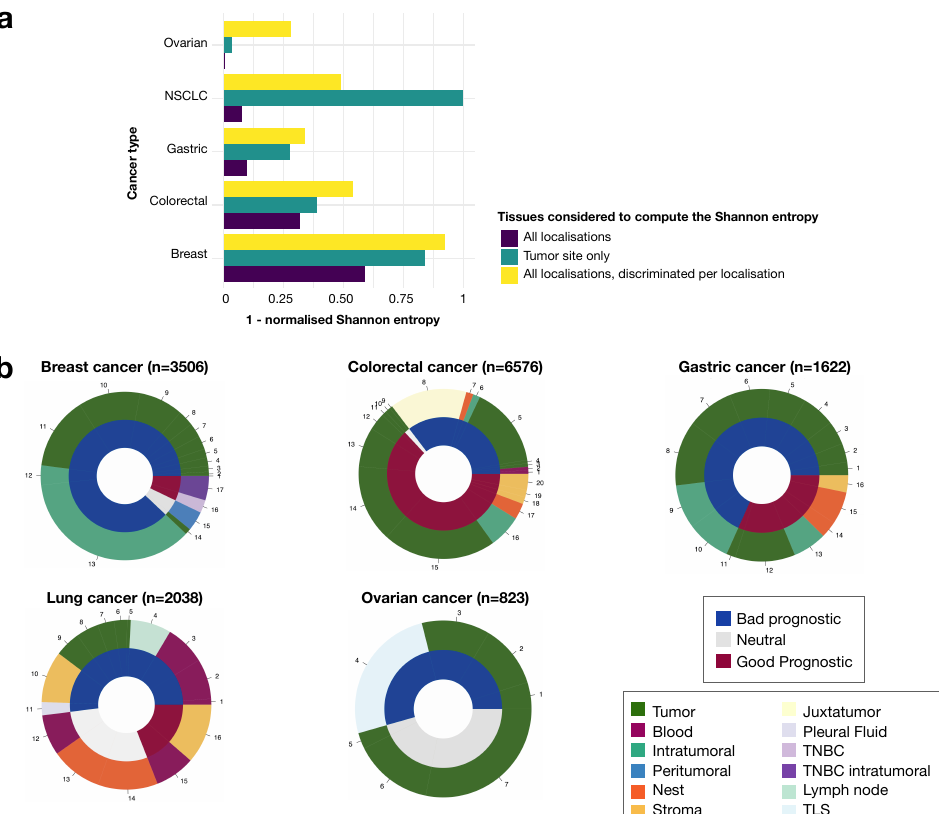
Figure 5. Interplay between Tregs, their anatomic locations and their prognostic value. ( a ) Histogram showing one minus the normalized Shannon entropy for each cancer type and for each group, by anatomic site: all locations together (dark blue), tumor site (dark green), and mean of the entropies for each anatomic site (yellow). ( b ) Pie charts of prognostic value by anatomic site, for each cancer type. Each numbered portion is an article and its size reflects the number of patients included in the study. (TNBC: triple-negative breast cancer; TLS: tertiary lymphoid